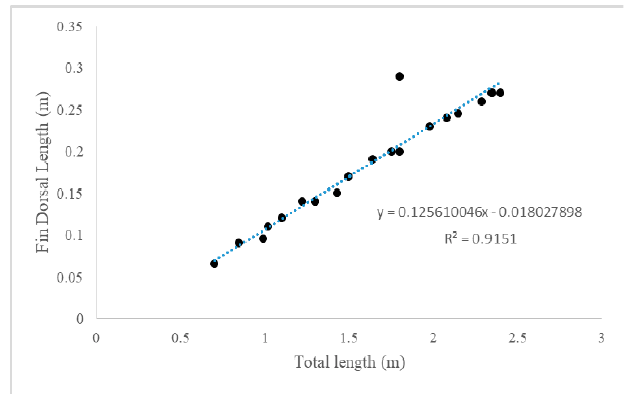
Figure 3. Relationship of dorsal fin length and the total length of silky sharks.